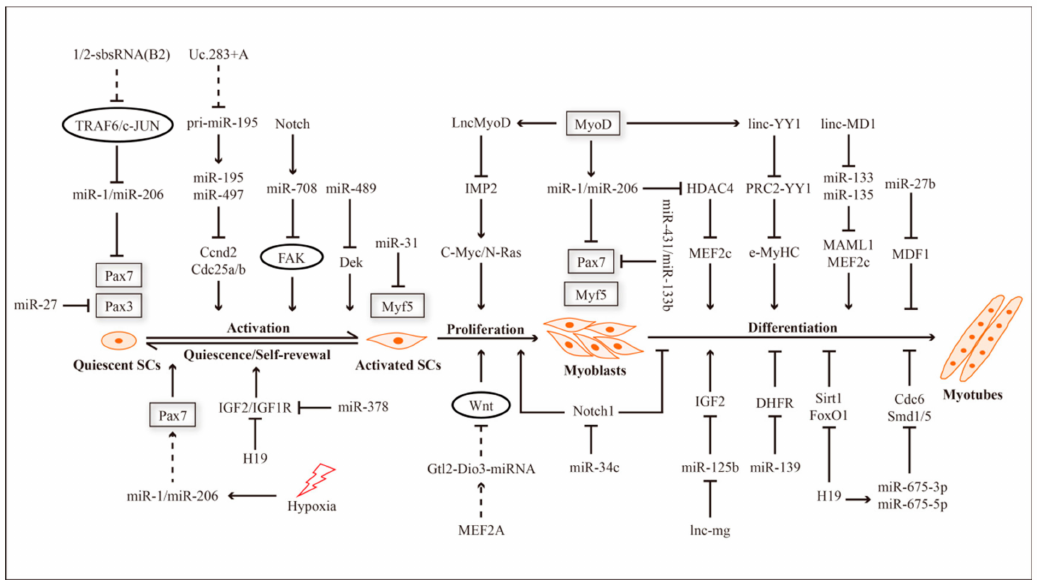
Figure 1. Non-coding RNA (ncRNA)-mediated regulatory networks in the myogenesis of skeletal muscle satellite